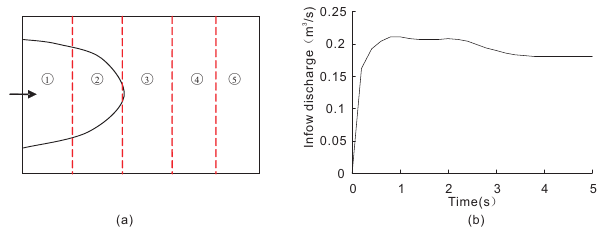
Figure 2. Idealized test of flood routing over a rectangular flood- plain induced by dyke breach: (a) computational domain; (b) hy- drograph of the inflow discharge Qi(t) . Table 1. The five groups of observations used in the test case of dyke-break flood routing over a flat bottom.